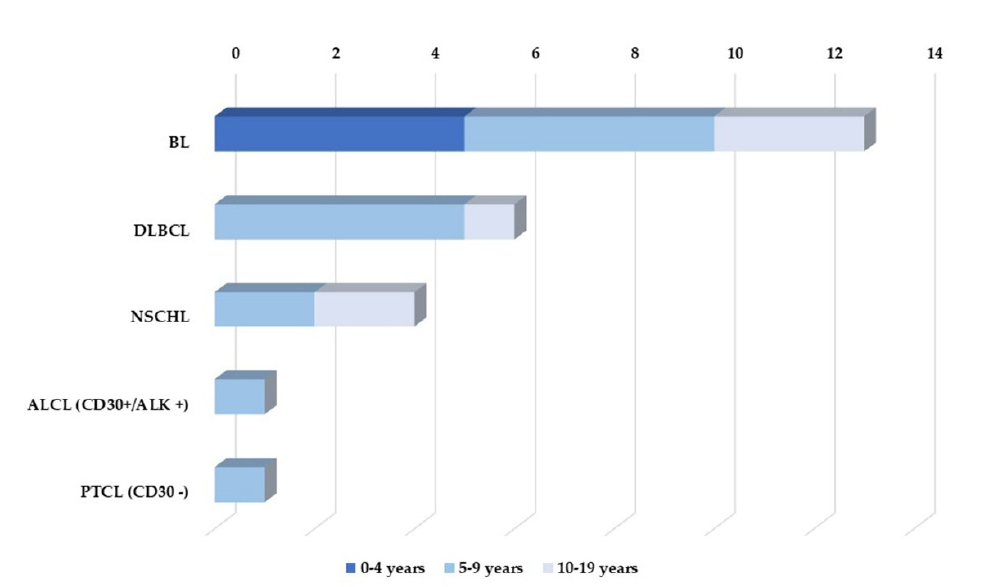
Figure 4. Lymphoma subtypes found in the cohort according to Age group at diagnosis. Abbrevia- tions: Anaplastic Large Cell Lymphoma (ALCL CD30+/ALK+); Burkitt Lymphoma (BL); Diffuse Large B-Cell Lymphoma (DLBCL); Nodular Sclerosis Classical Hodgkin Lymphoma (NSCHL); Pe- ripheral T-Cell Lymphoma